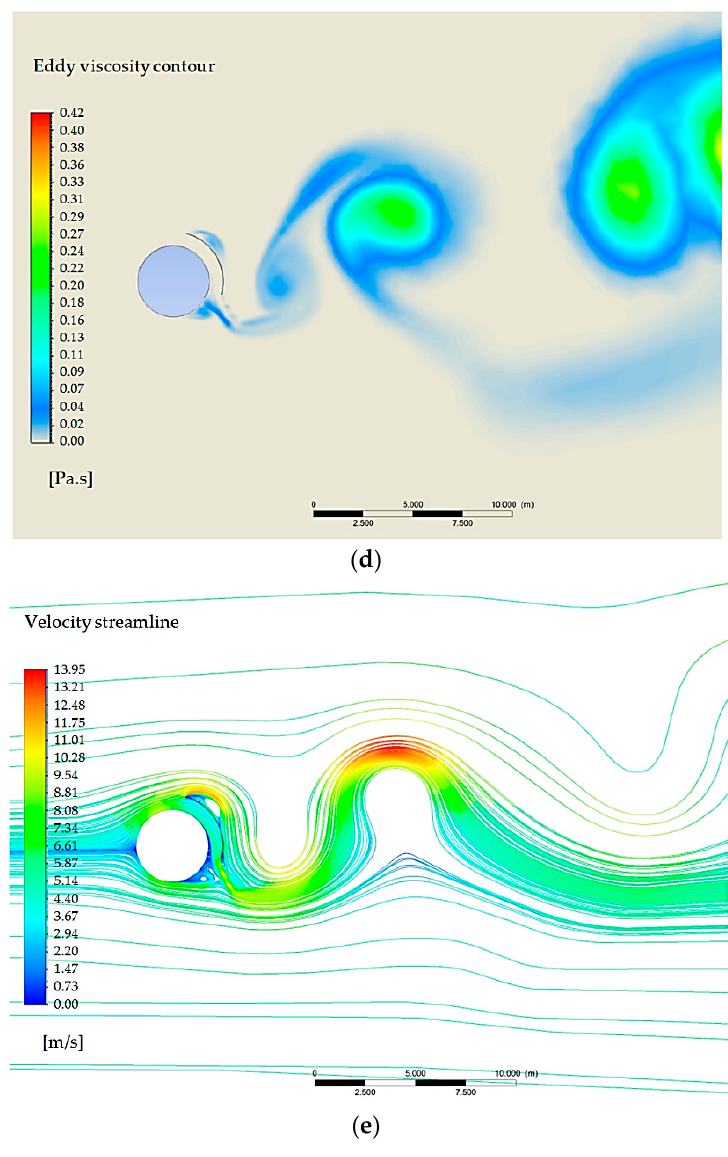
Figure 4. Contours of temperature, velocity, pressure, eddy viscosity, and velocity streamlines around the kiln in the presence of the absorber. Table 4. Average heat transfer features on the kiln surface in the presence of the absorber.